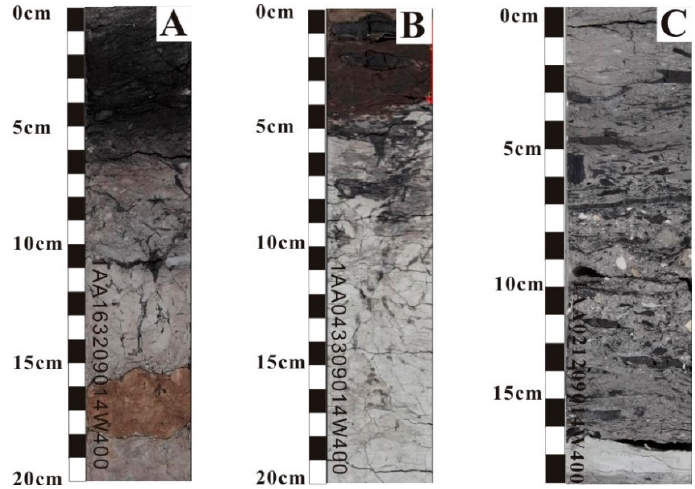
Figure 6. Rootlets ( A , B ) and carbonaceous debris ( C ).